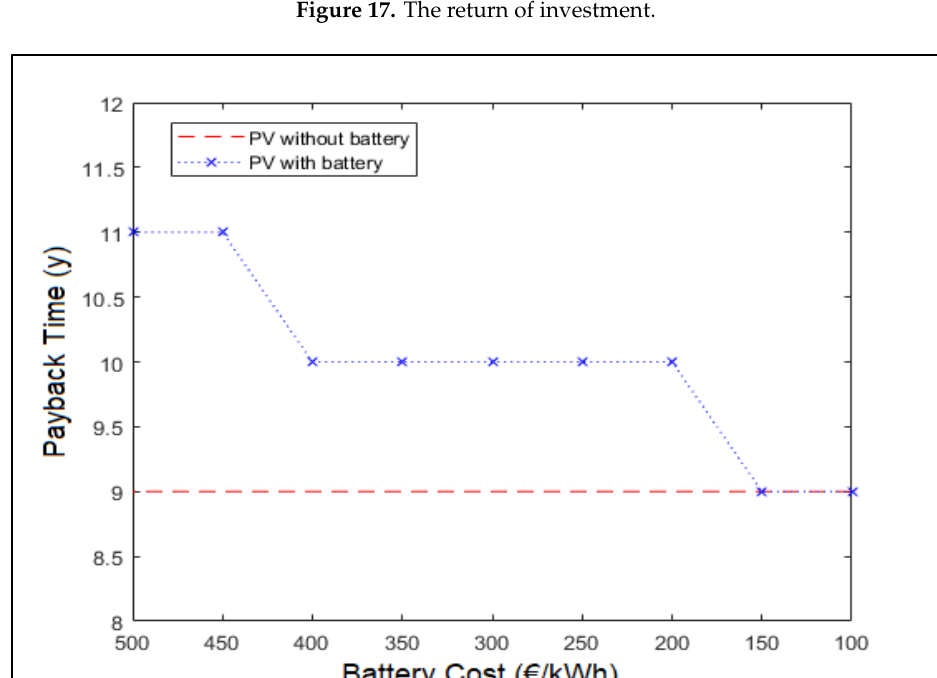
Figure 17. The return of investment.